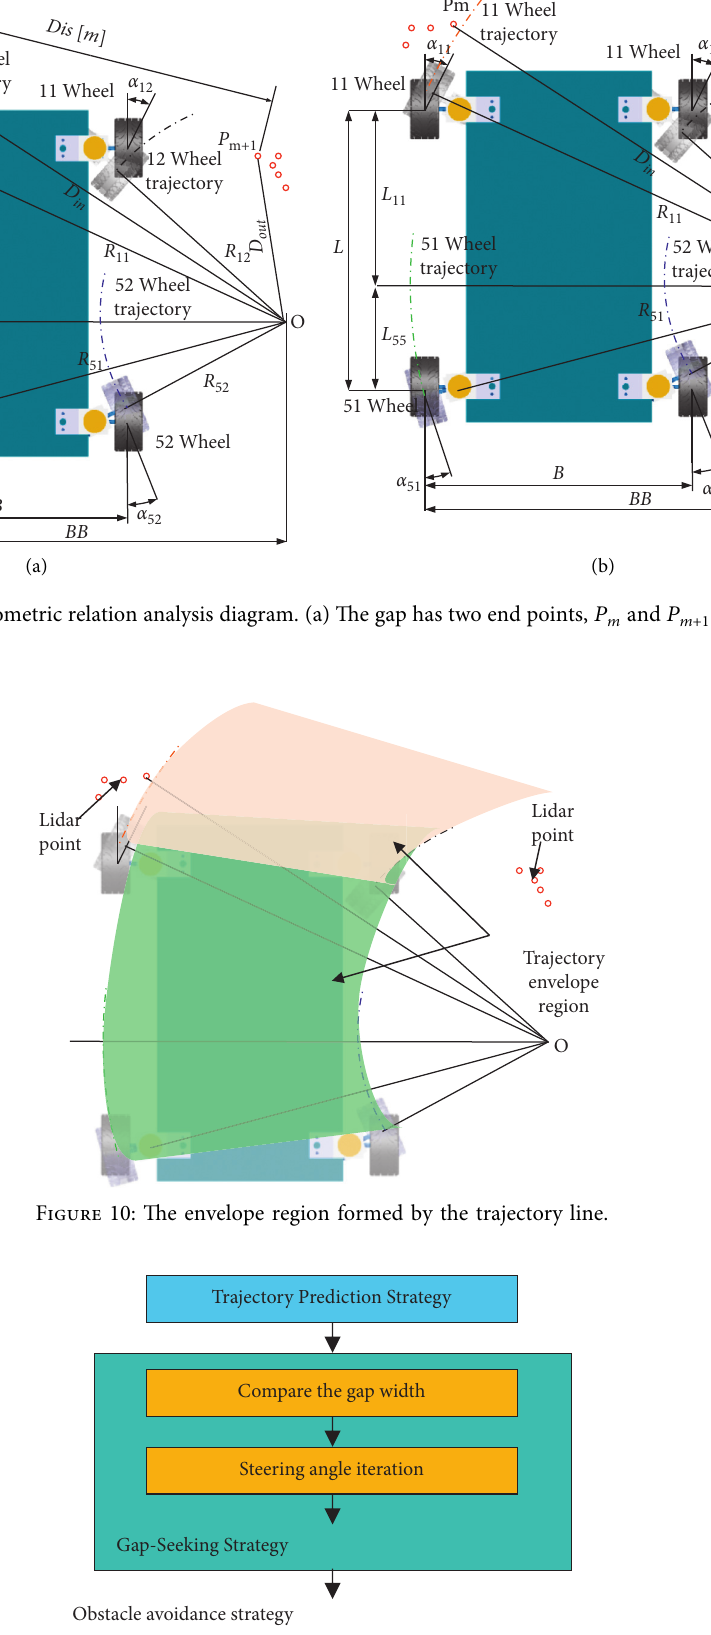
Figure 11: Obstacle avoidance strategy based on trajectory